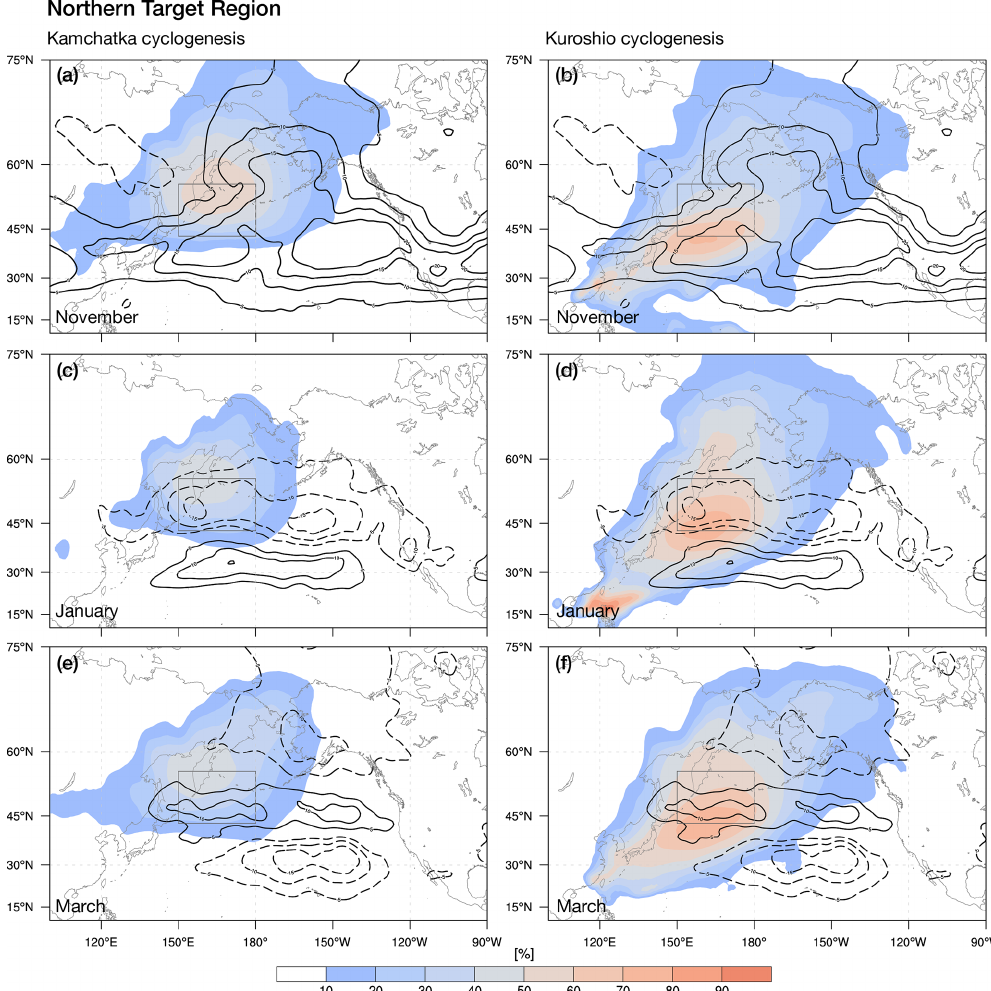
Figure 3. Relative contributions (color shading; %) of (a, c, e) Kamchatka cyclones and (b, d, f) Kuroshio combined with East China Sea cyclones to the total surface-cyclone frequency in the northern target region (gray box). The contours show the change in EKE relative to the corresponding previous month (solid lines are for positive values and dashed lines for negative values; − 20 to 20Jkg − 1 by steps of 5Jkg − 1